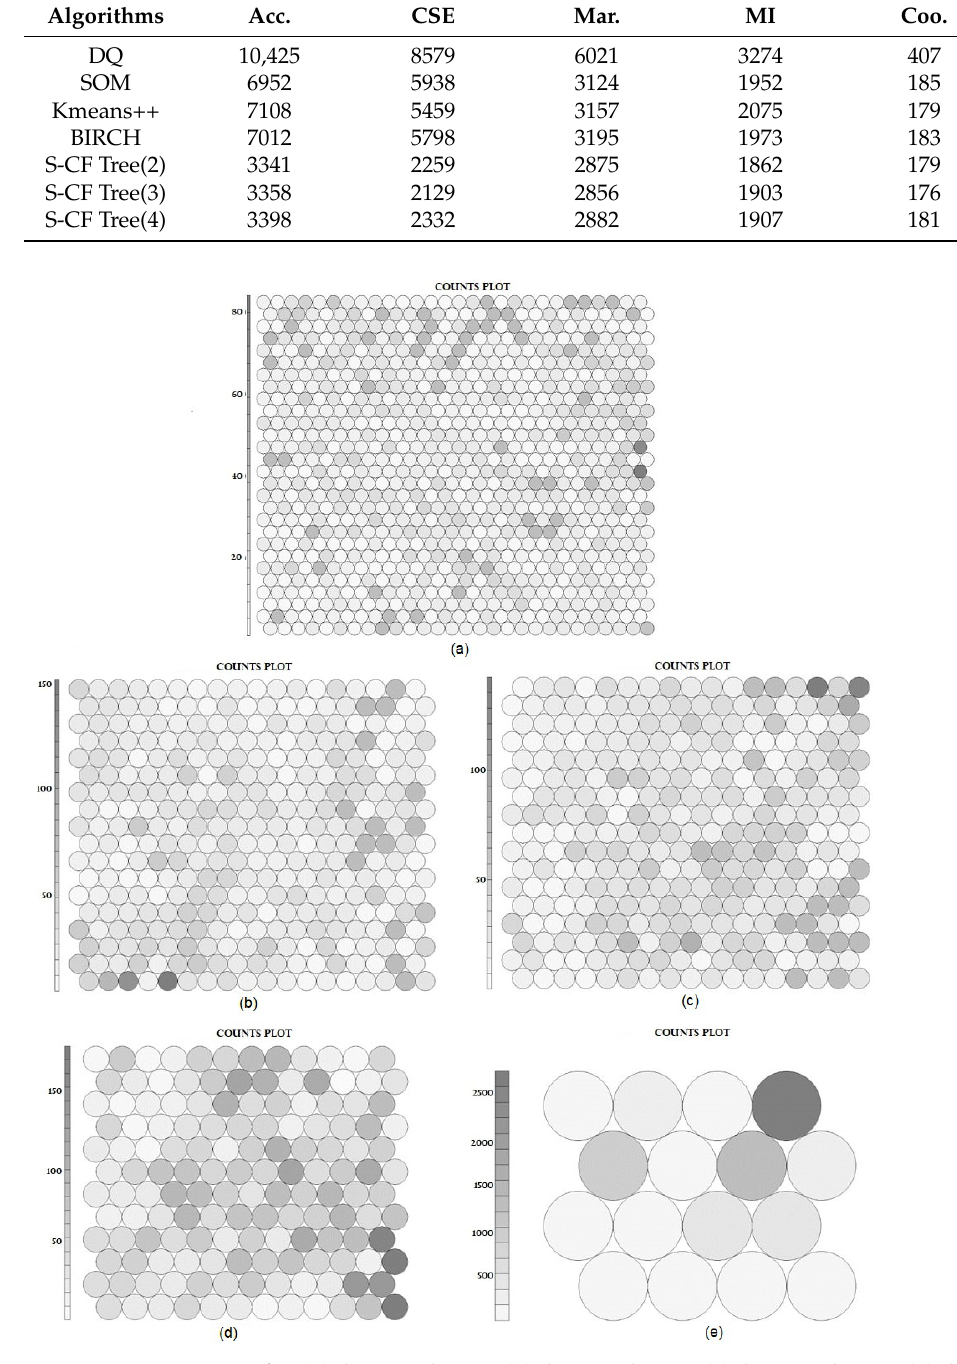
Figure 5. SOM patterns for: ( a ) the Acc. dataset; ( b ) the CSE dataset; ( c ) the Mar. dataset; ( d ) the MI dataset; ( e ) the Coo.